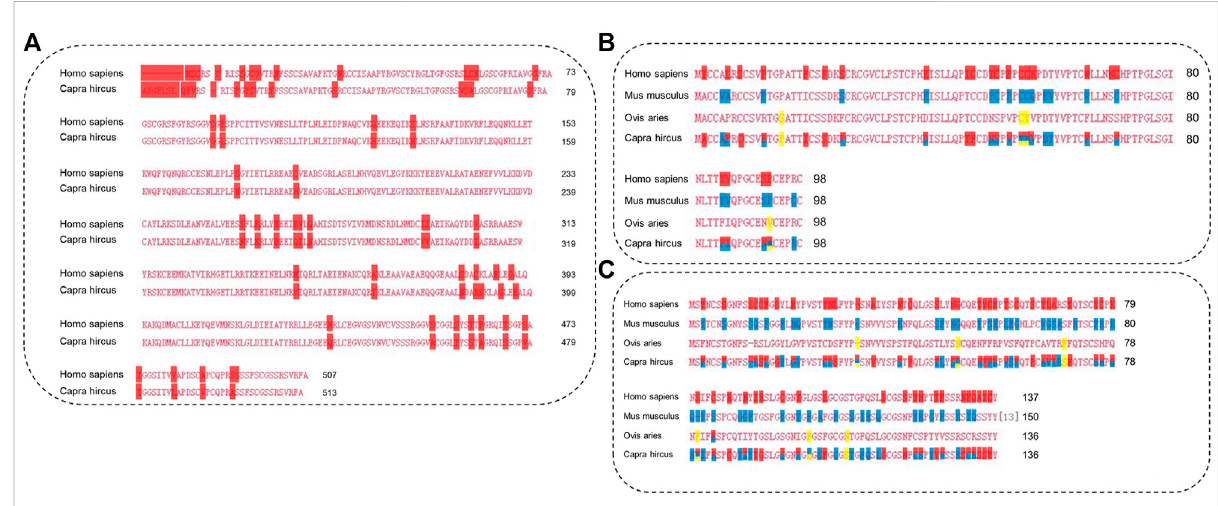
The amino acid sequences of proteins were analyzed by multiple sequence alignment. (A) . Multiple sequence alignment of KRT85. (B) . Multiple sequence alignment of KRTAP3-1. (C) . Multiple sequence alignment of KRTAP15-1.